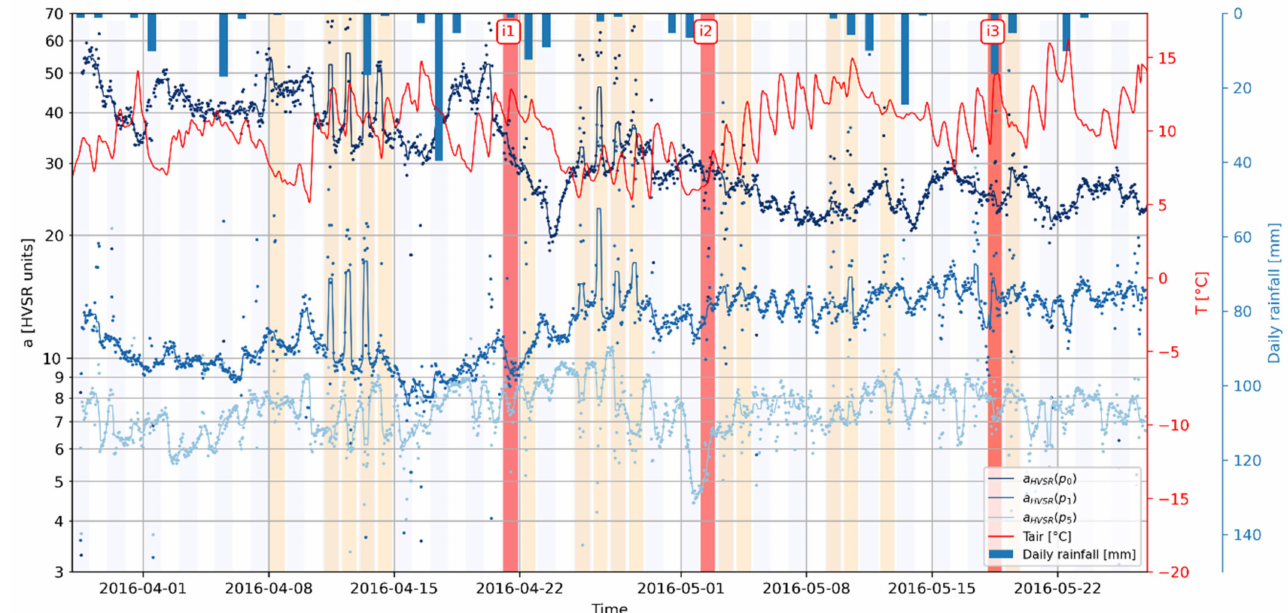
Figure 6. HVSR amplitude of peaks p 0 , p 1 , and p 5 with time (logscale on Y-axis). Continuous lines show the rolling median computed on 12 h long windows. Air temperature on-site is shown as red curve, and daily rainfall is shown as blue bars (downwards axis). Reinforcement work stages are shown in the background: drilling days (light orange) and grout injection